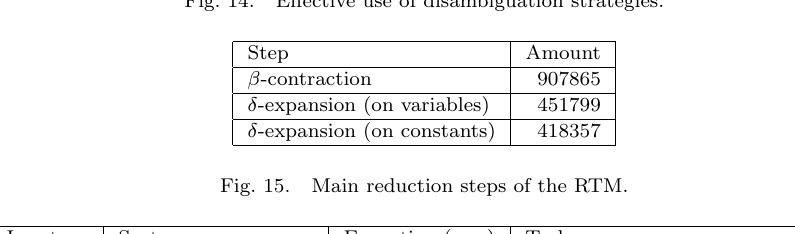
Fig. 14. Effective use of disambiguation strategies.